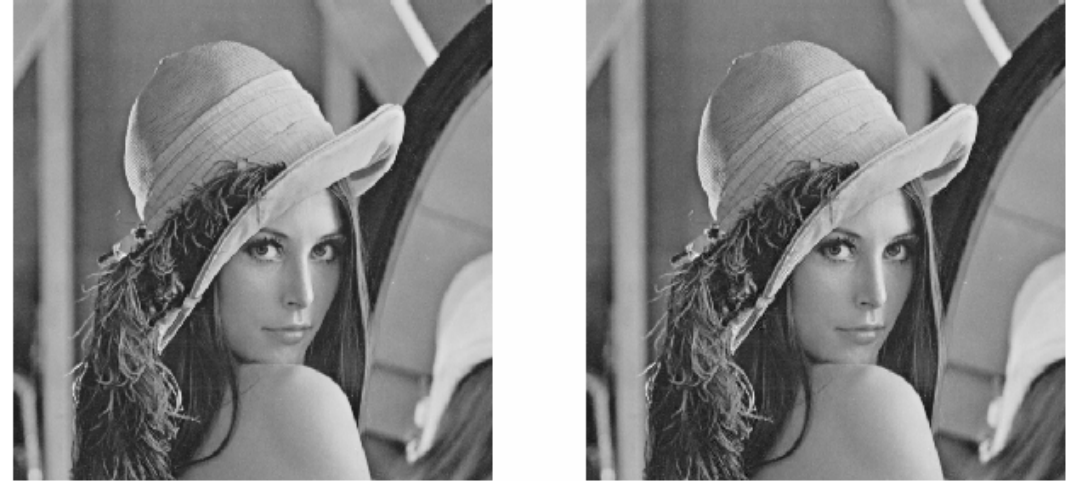
Figure 2. Original “Lena” image on the left; watermarked image on the right (PSNR = 37.6752